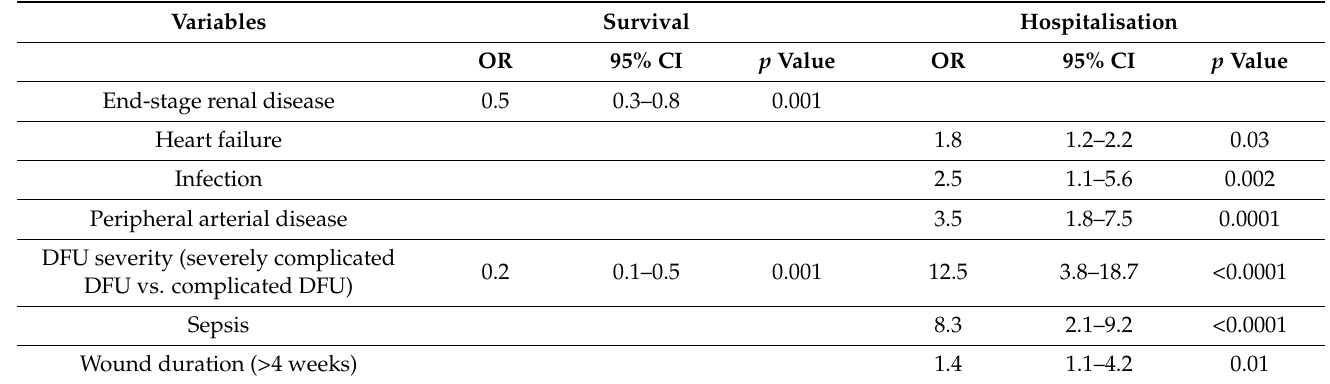
Table 5. Multivariate analysis of independent predictors of outcomes (survival and hospitalization) found via univariate analysis. End-stage renal disease and DFU severity were independent predictors of survival; heart failure, infection, and peripheral arterial disease, DFU severity, sepsis, and wound duration were independent predictors of hospitalization. DFU: diabetic foot